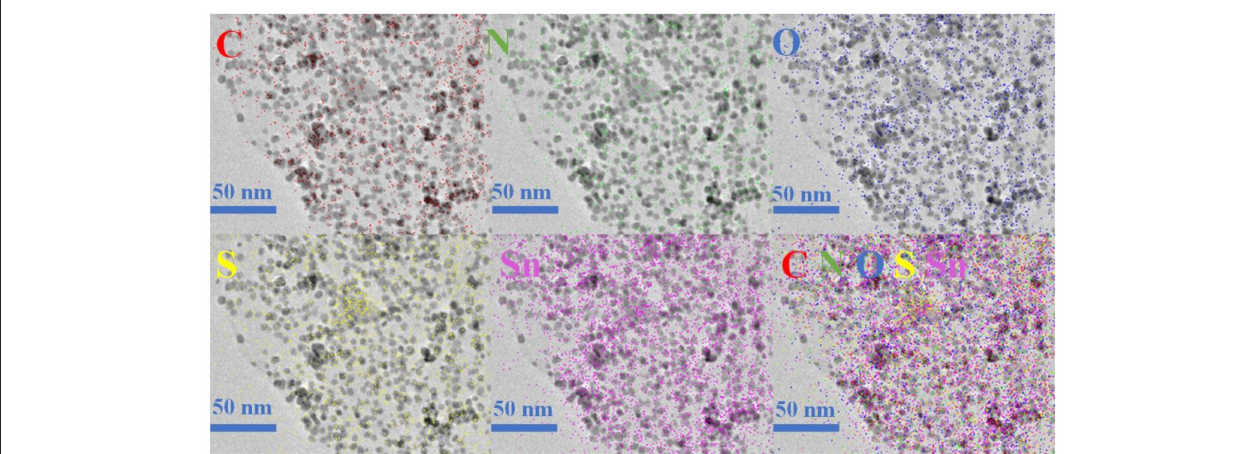
FIGURE 4 | EDS mapping images of SnO 2 -SnS 2 @C/NG composite.